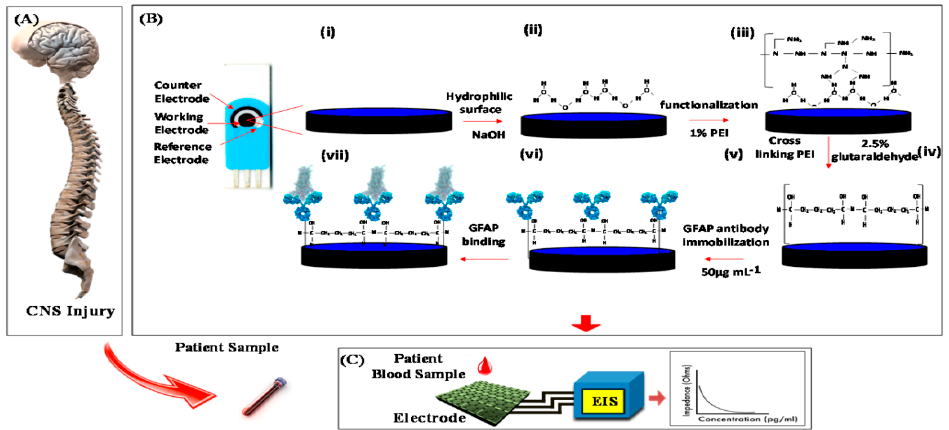
Figure 2. Schematic representation of the modification of a graphene electrode surface, sample collection, and electrochemical detection of glial fibrillary acidic protein (GFAP): ( A ) Blood collected from central nervous system (CNS) injury patient, or samples are prepared in artificial cerebrospinal fluid and in blood serum. ( B ) Stages of surface modification for binding the GFAP antibody to the functionalized graphene electrode: (i) Bare graphene electrode, (ii) sodium hydroxide (NaOH) treatment for creating hydrophilic surface, (iii) functionalization of polyethylenimine (PEI), (iv) activation of the surface with glutaraldehyde, (v) Schiff base, (vi) immobilization of GFAP antibody, (vii) blocking unbounded sites, and (viii) immunosensor ready for the detection. ( C ) Detection of electrochemical impedance spectroscopy (EIS) response of the immunosensor for GFAP detection. Reproduced with permission from [45].